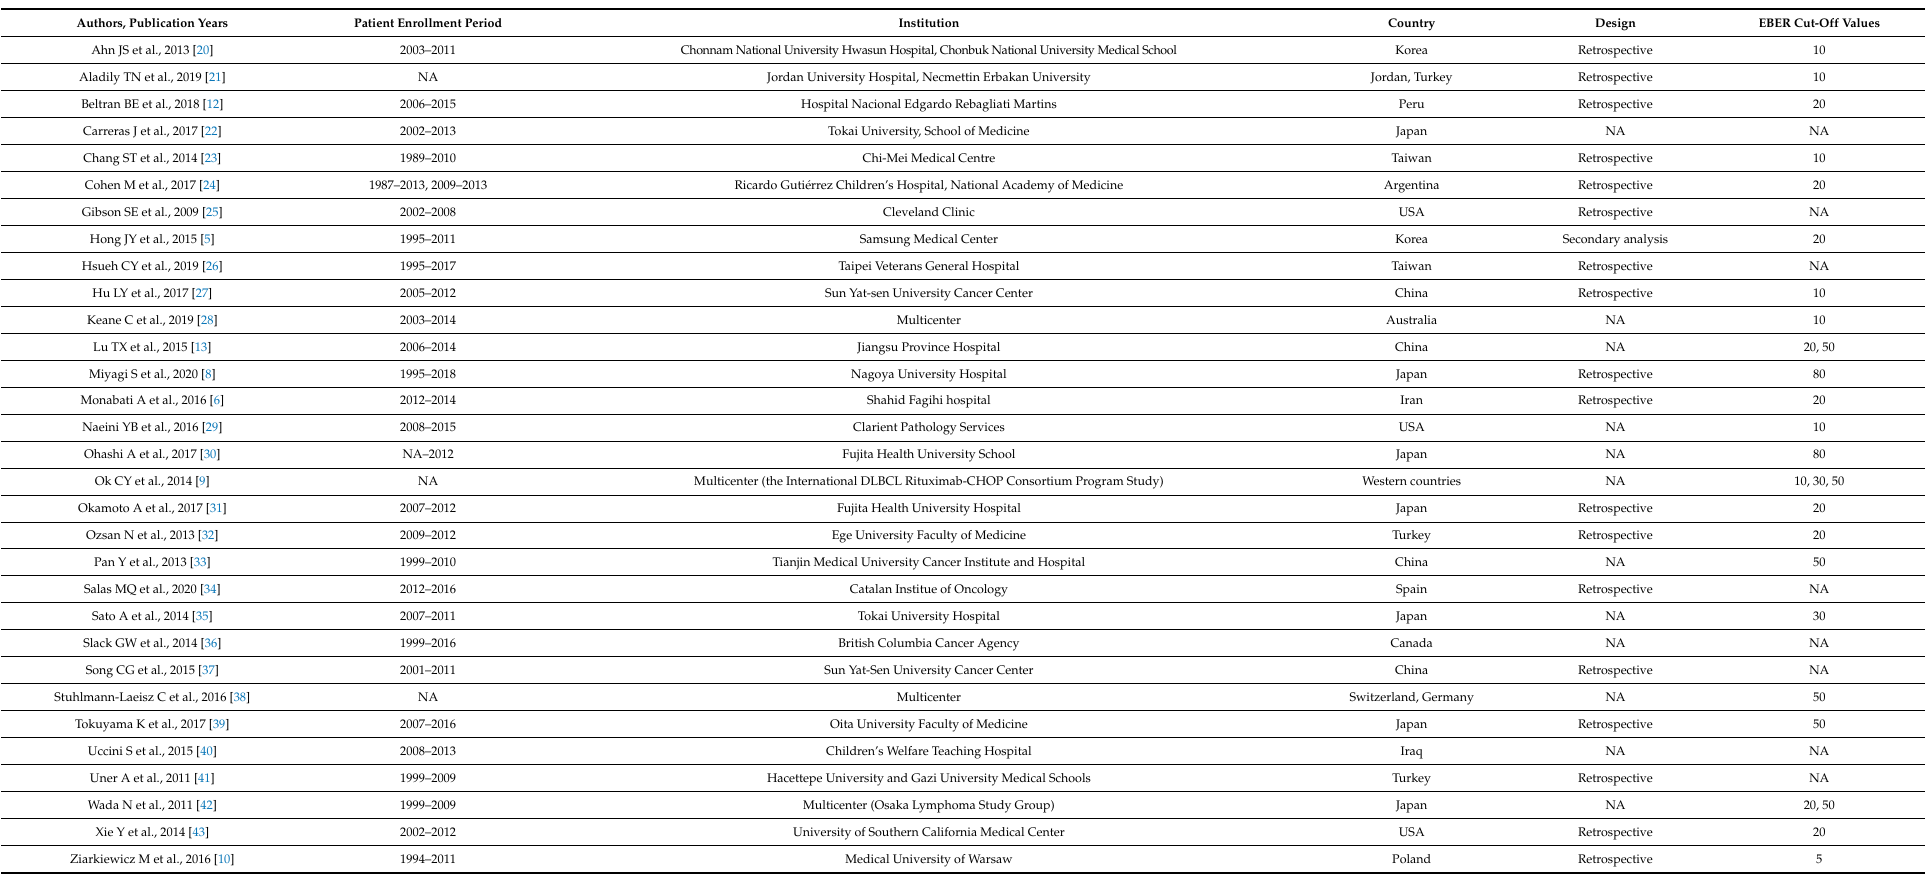
Table 1. Main characteristics of the included